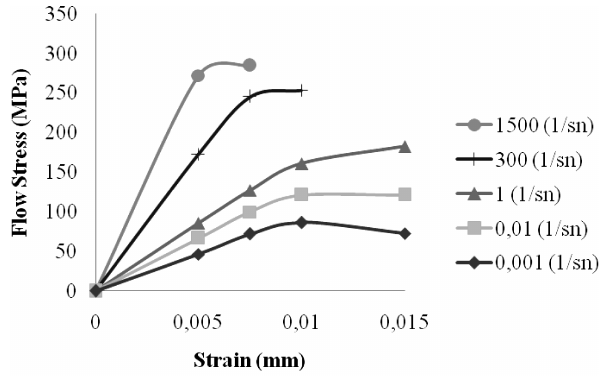
Figure 8. Flow stress of bone (McElhaney and Byars, 1965).